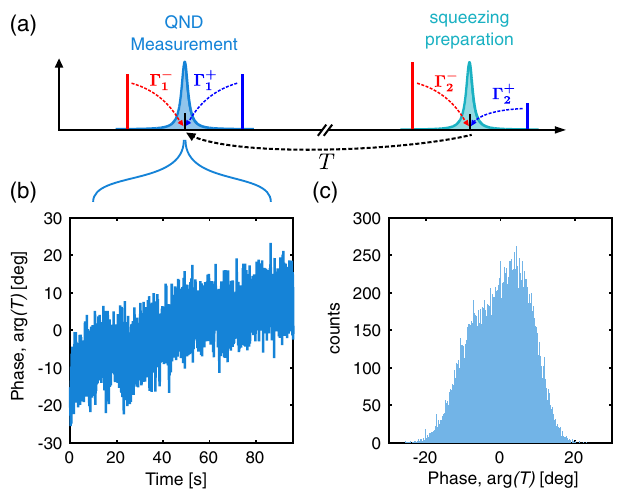
FIG. 8. System phase stability. (a) Measurement schematic. The device is driven by four drives, at ω (cid:1) 1 applied at ω ≈ ω 2 and received at ω − ω − 2 þ ω − 1 ≈ ω 1 . (b) Phase of the transmission coefficient as a function of time. (c) Histogram of the time trace measured in